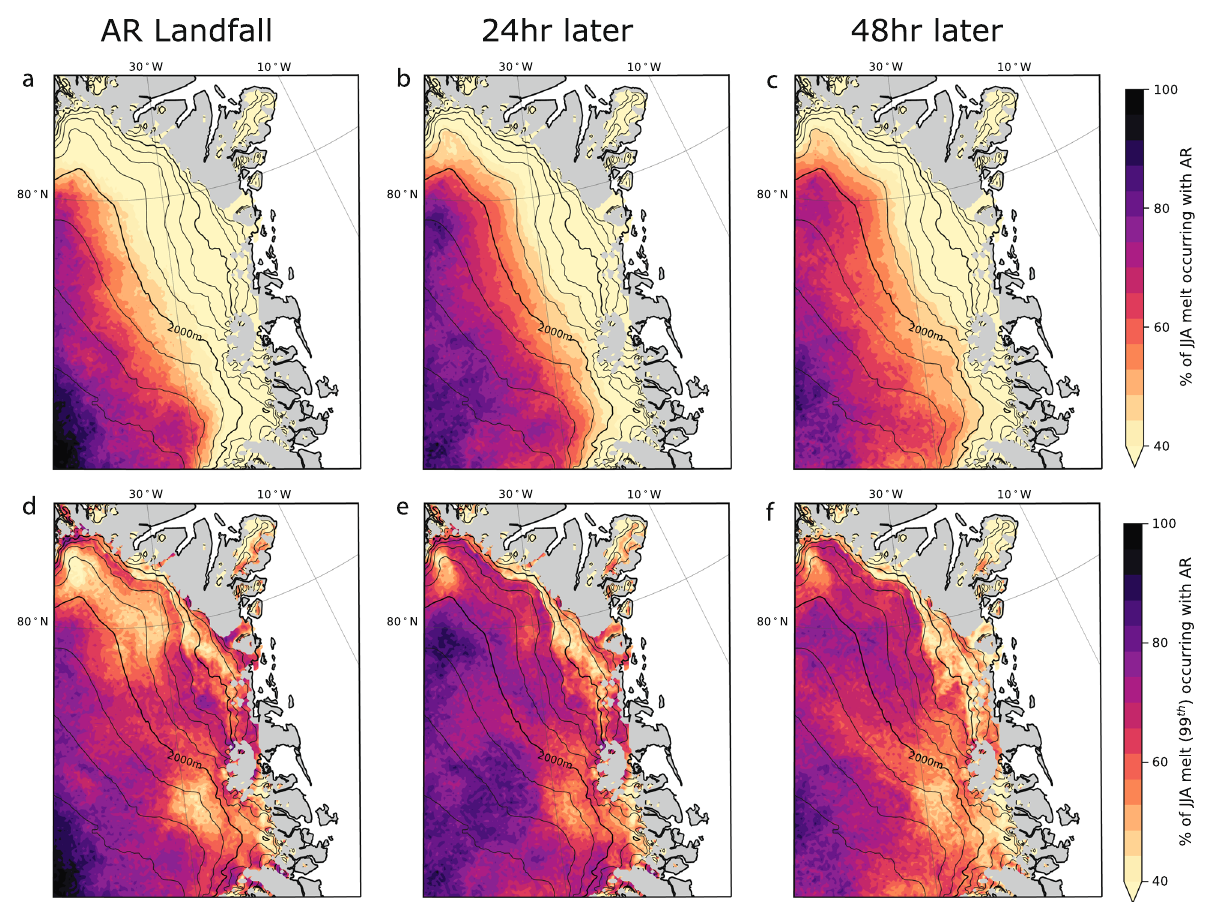
Fig. 2 | Percentage of summer (JJA) surface melt attributable to atmospheric rivers (ARs). a – c The percentage of polar Regional Atmospheric Climate Model version 2.3p2 (RACMO2) simulated summer (JJA) daily surface melt and d – f the percentage of surface melt at or above the 99th percentile of the